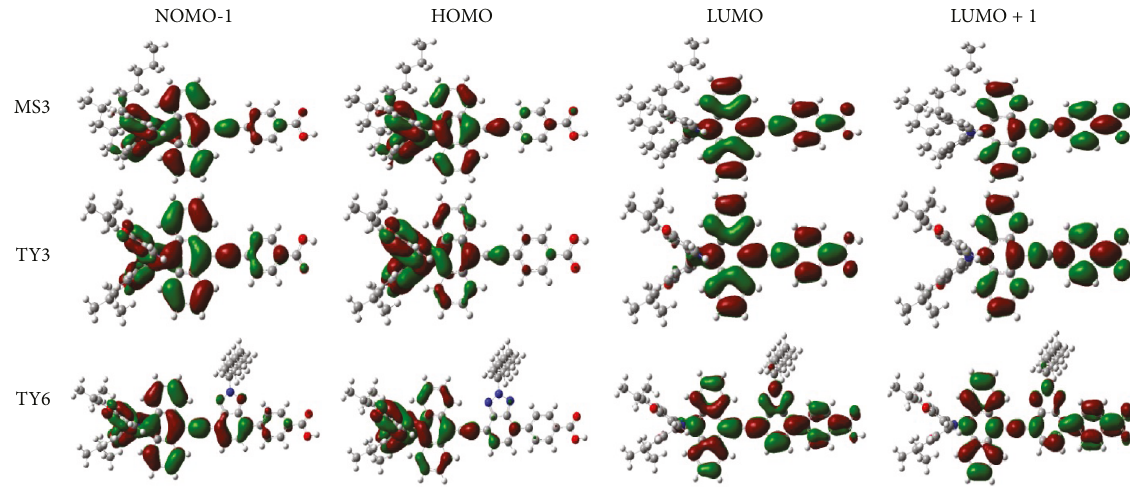
Figure 4: Frontier molecular orbitals of MS3, TY3, and TY6.